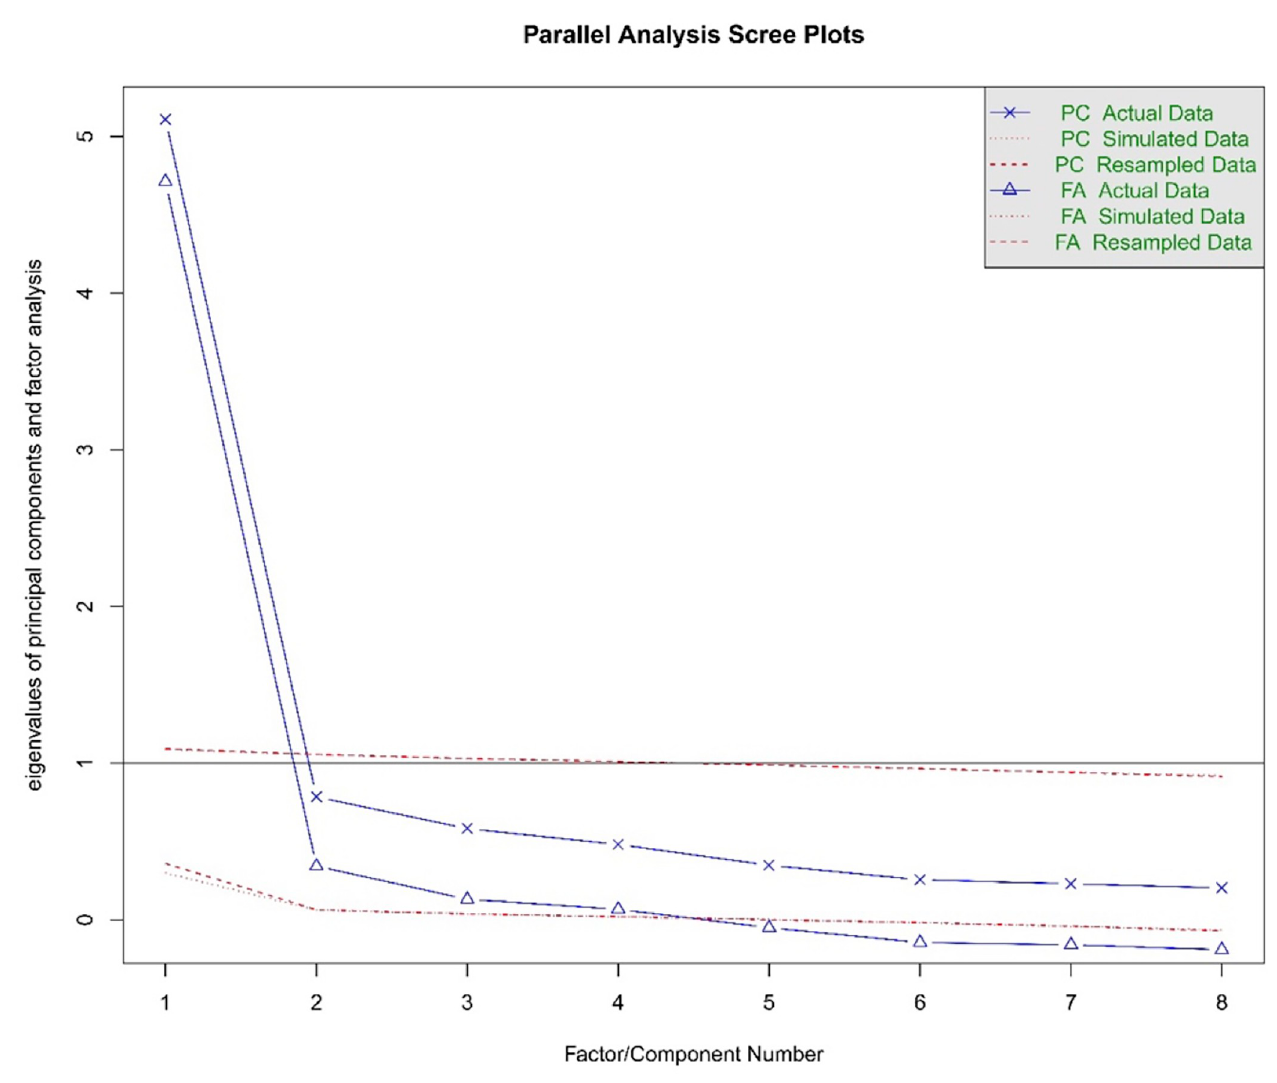
Fig 1. Parallel analysis of the